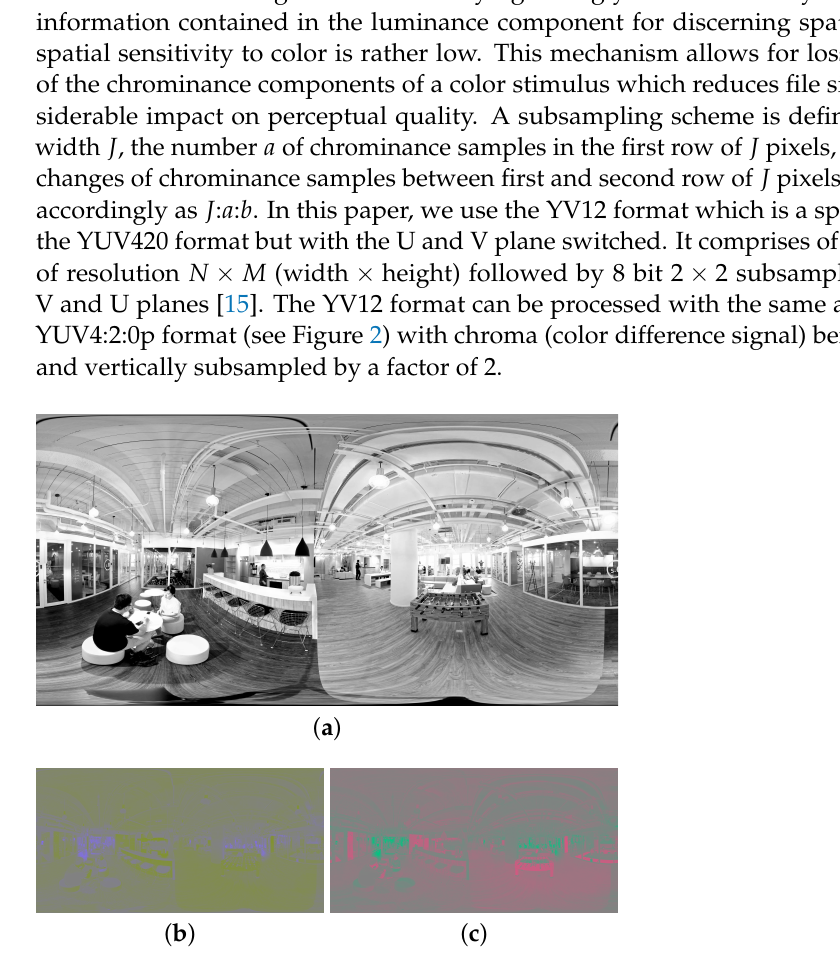
Figure 2. YUV4:2:0 color encoded equirectangularly projected frame of a 360 ◦ video: ( a ) Y component, ( b ) U component, ( c ) V